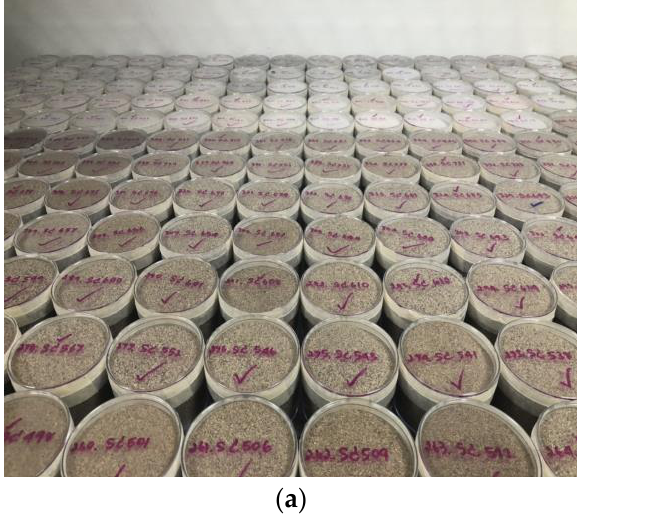
Figure 2. Sand samples ( a ) and the gamma-ray detector ( b ).